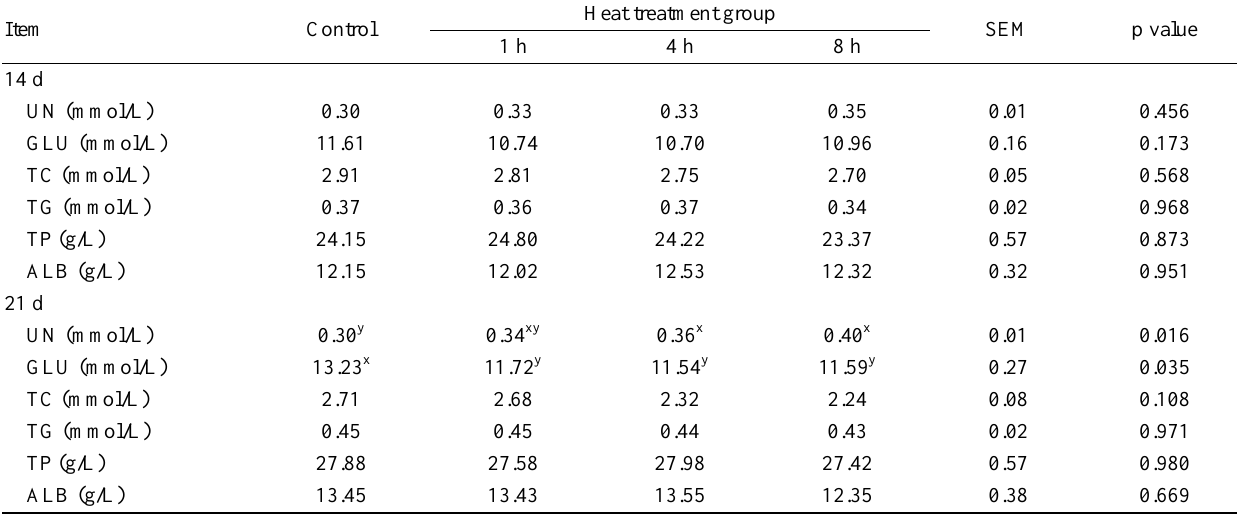
Table 3. Effects of heat-oxidized soy protein isolate on serum biochemical indices of broilers